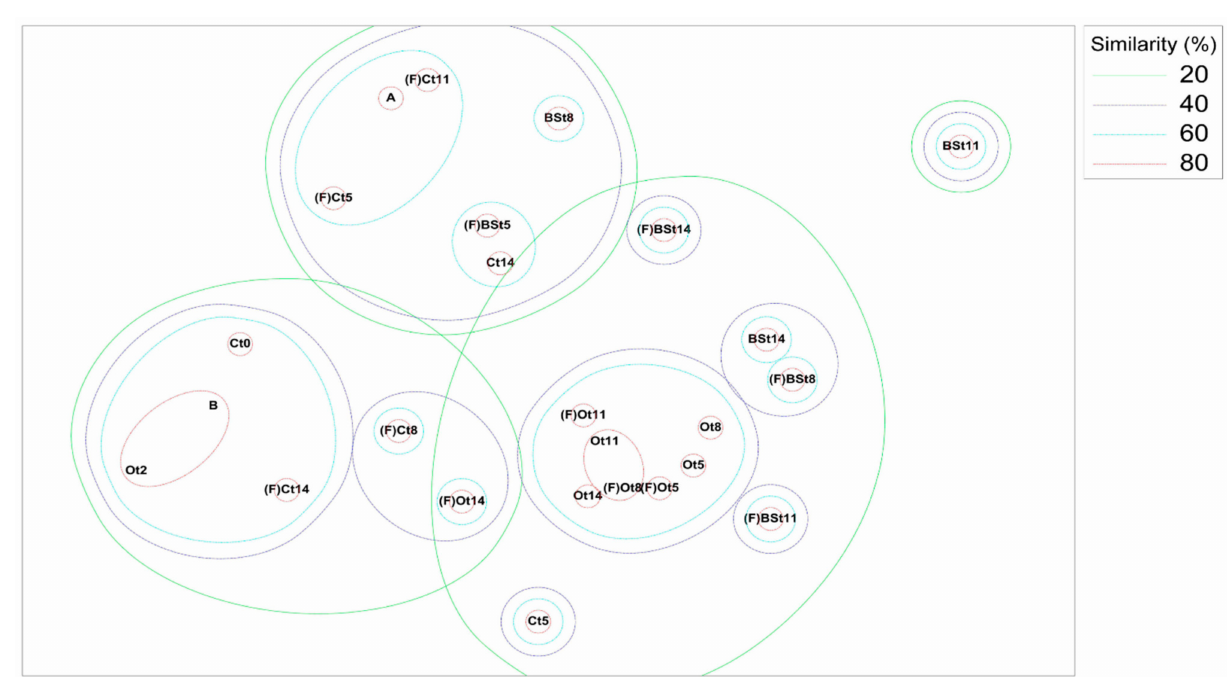
Figure 1. Nonmetric multidimensional scaling (NMDS) ordination of bacterial automated ribosomal intergenic spacer analysis (ARISA) community composition based on Bray–Curtis distances (stress = 0.13)). Sample IDs are represented as follows: Freeze–thaw cycle (FTC) regime (F) (if applied) + treatment (control (C); nutrient amendment (BS); oil (O)) + collection time (t). Points A and B represent samples plotted in the same site: A: BSt0, BSt2, and BSt5; B: Ct2, Ct8, Ct11, Ct14, and